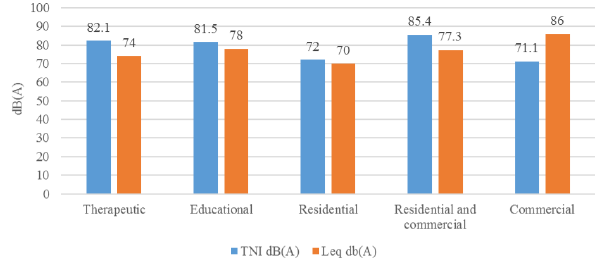
Figure 3: Mean TNI and L eq in five uses